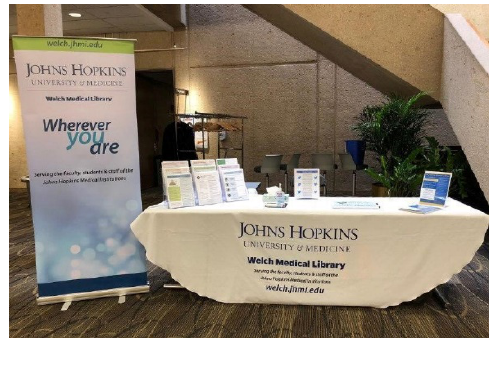
Figure 3 The librarian’s exhibitor hall